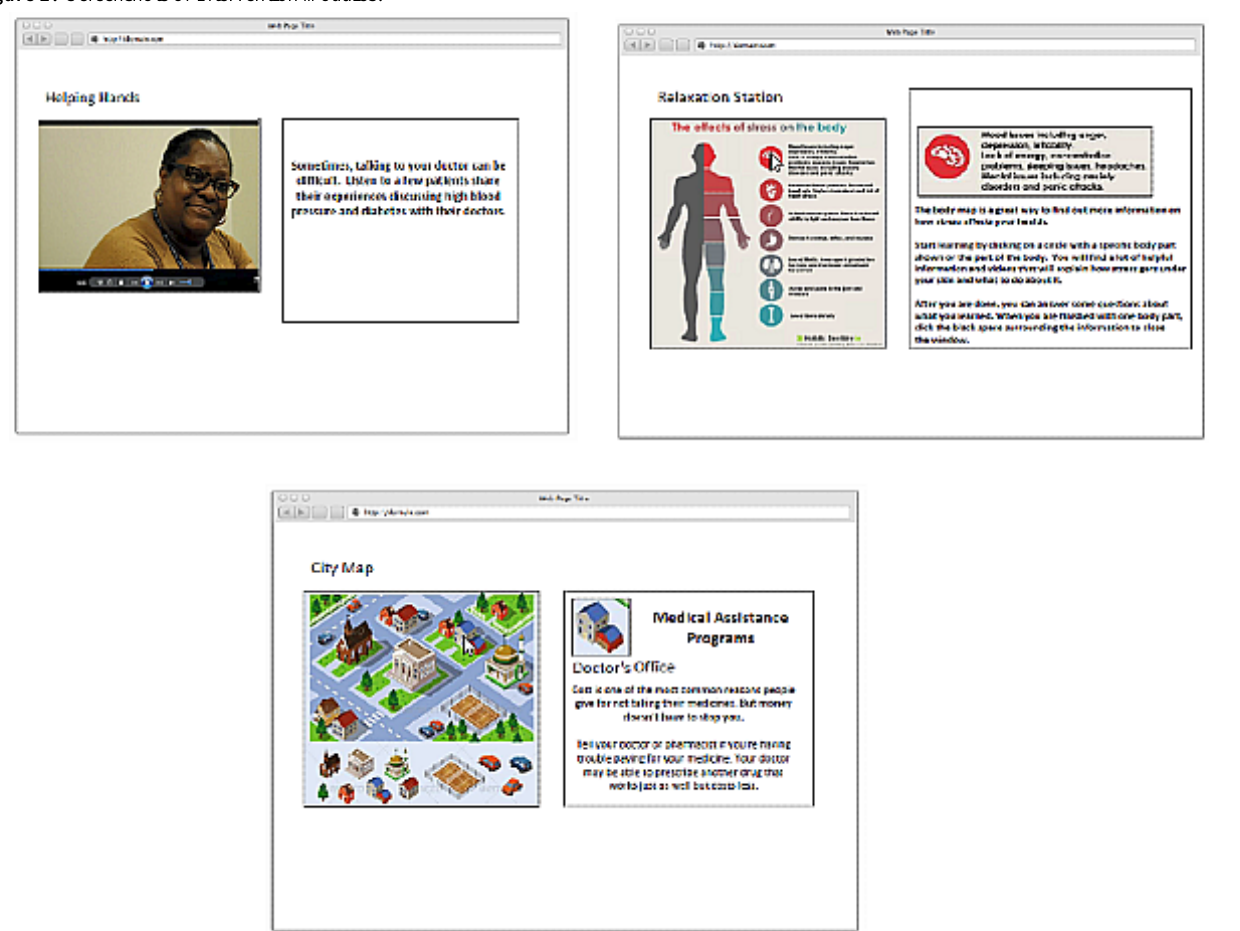
Figure 2. Screenshots of intervention